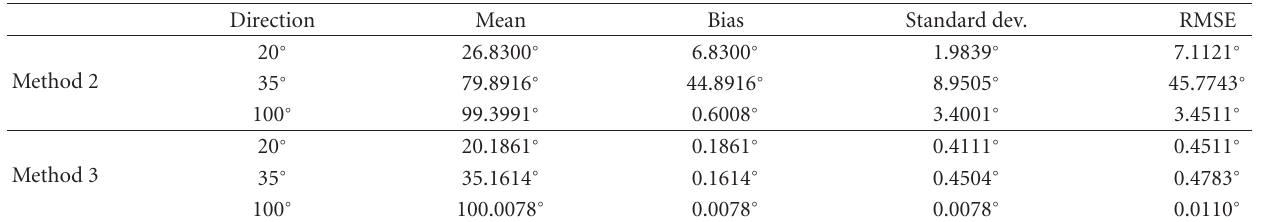
Table 2: DOA estimation using MPM and a ULA with 8 antenna elements with the element separation of Δ = 0 . 15 λ . DOA estimation is based on the decoupled voltages using the RMI determined based on methods 2 and